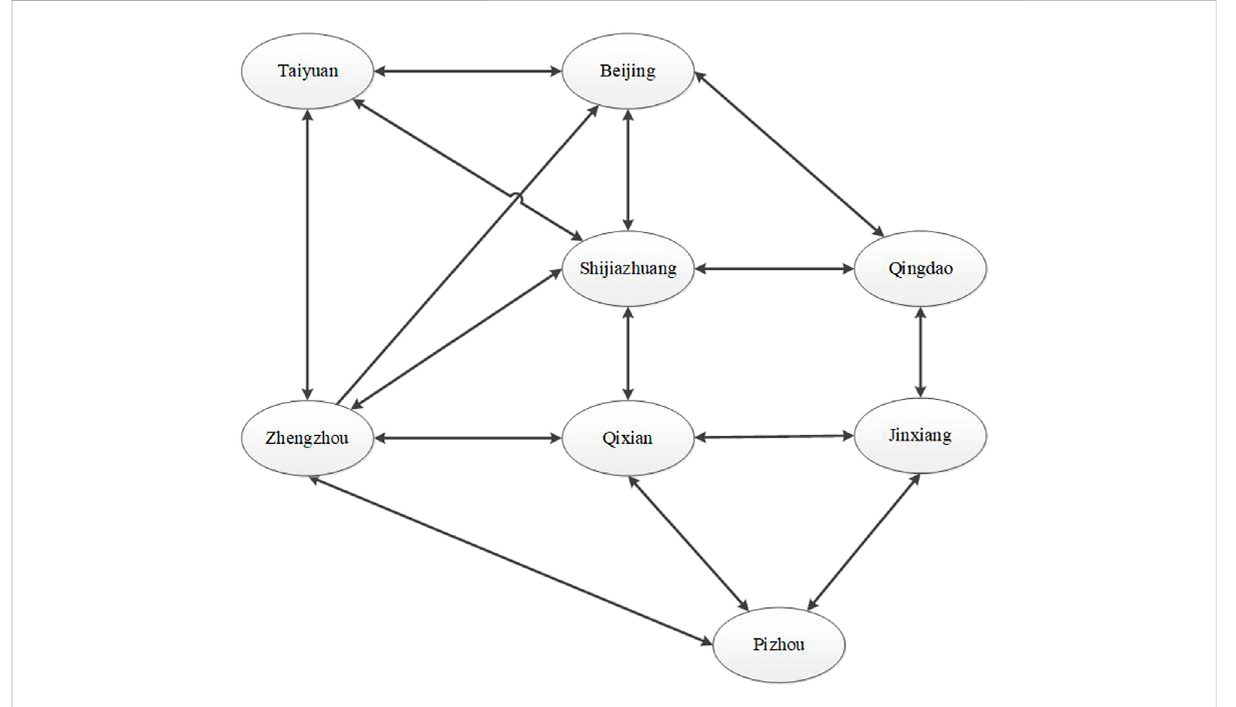
FIGURE 2 Directions of garlic price